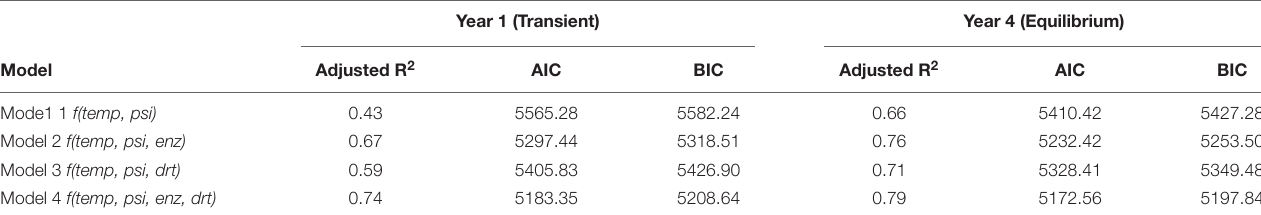
FIGURE 4 | Enzyme investment vs. drought tolerance by the end of year 1 and year 4 after the transplant. (A,B) Are under the average forcing, while (C,D) are under the actual forcing. Data are pooled together across the gradient and color-coded by site. TABLE 1 | Regression models predicting annual litter decomposition as a linear function of temperature, water potential, enzyme investment trait, and/or drought tolerance